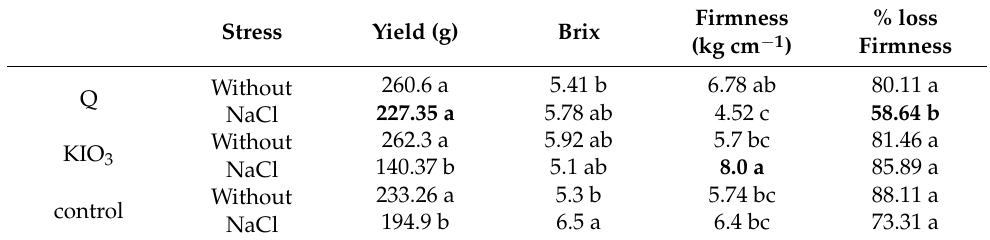
Table 8. Effect of iodine-based products on fruit quality and